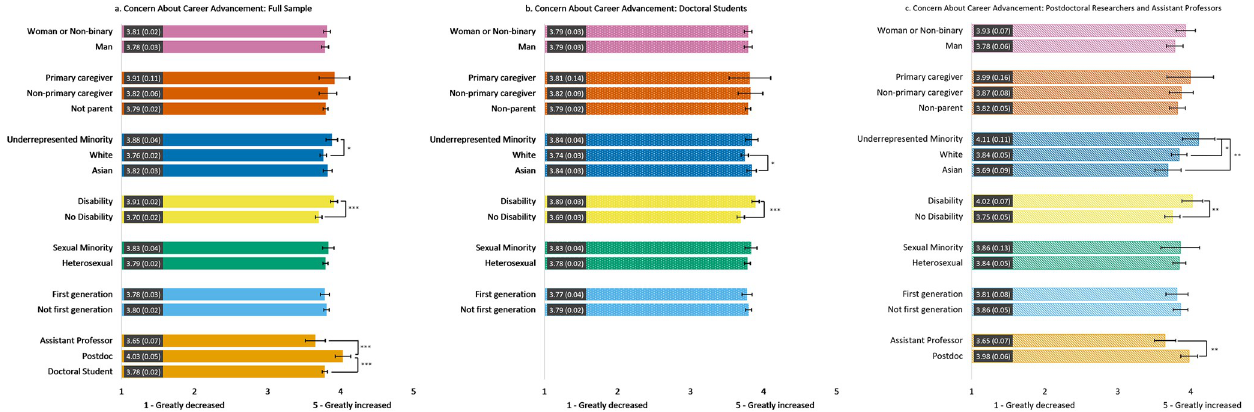
Fig 3. Estimated marginal means of reported change in concern about career advancement due to the COVID-19 pandemic for the full sample (3a) and doctoral student (3b) and postdoc/asst prof (3c) subsamples. Participants were asked to rate the degree to which their concern about career advancement changed on a Likert scale from 1 = Greatly decreased to 5 = Greatly increased . Error bars represent the 95% CI. Numeric values in each bar are the estimated marginal mean and standard error. � indicates p < .05, �� indicates p < .01, and ��� indicates p < .001. See S5 Table in S1 File for results of each model.